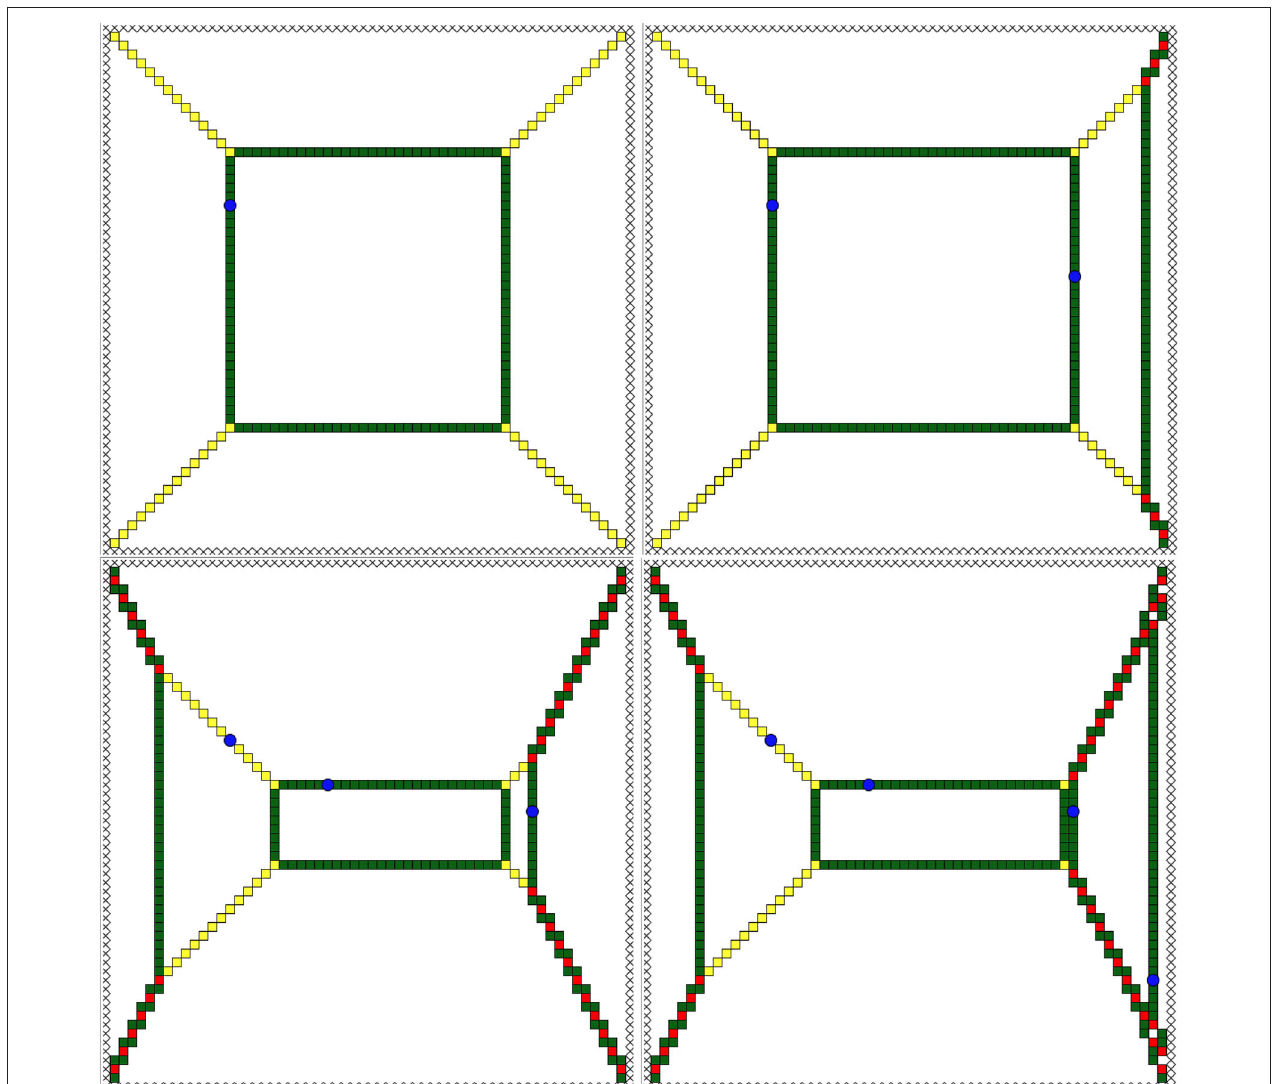
FIGURE 1 | (cid:127) is a square [0,100] × [0,100], we put 3 grains at every vertex of the lattice inside (cid:127) and drop 1 additional grain to each blue point (sequentially). The result of the relaxation after one additional grain is on the top-left picture. Then we added a grain of sand to the second blue point and performed a relaxation, the result of which is the top-right picture. The third picture is the bottom left one, and the last one is the bottom right one. White is three grains, green is two, yellow is one, and red is zero. Crosses mark the sinks in the model.